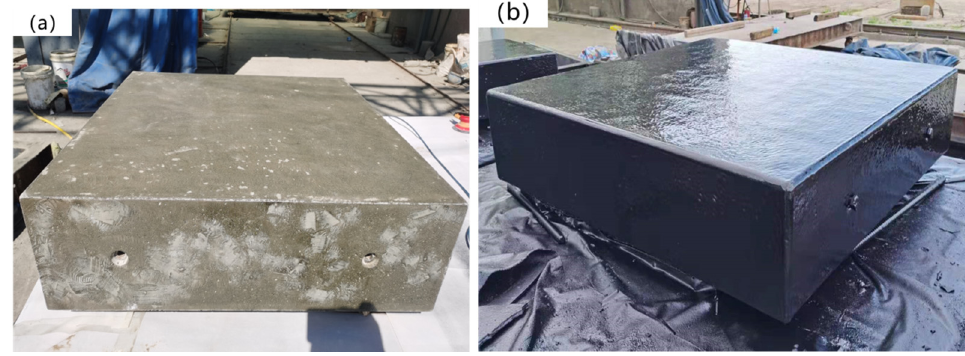
Figure 2. Samples of reinforced concrete slab: ( a ) painted primer; ( b ) sprayed T26 polyurea.